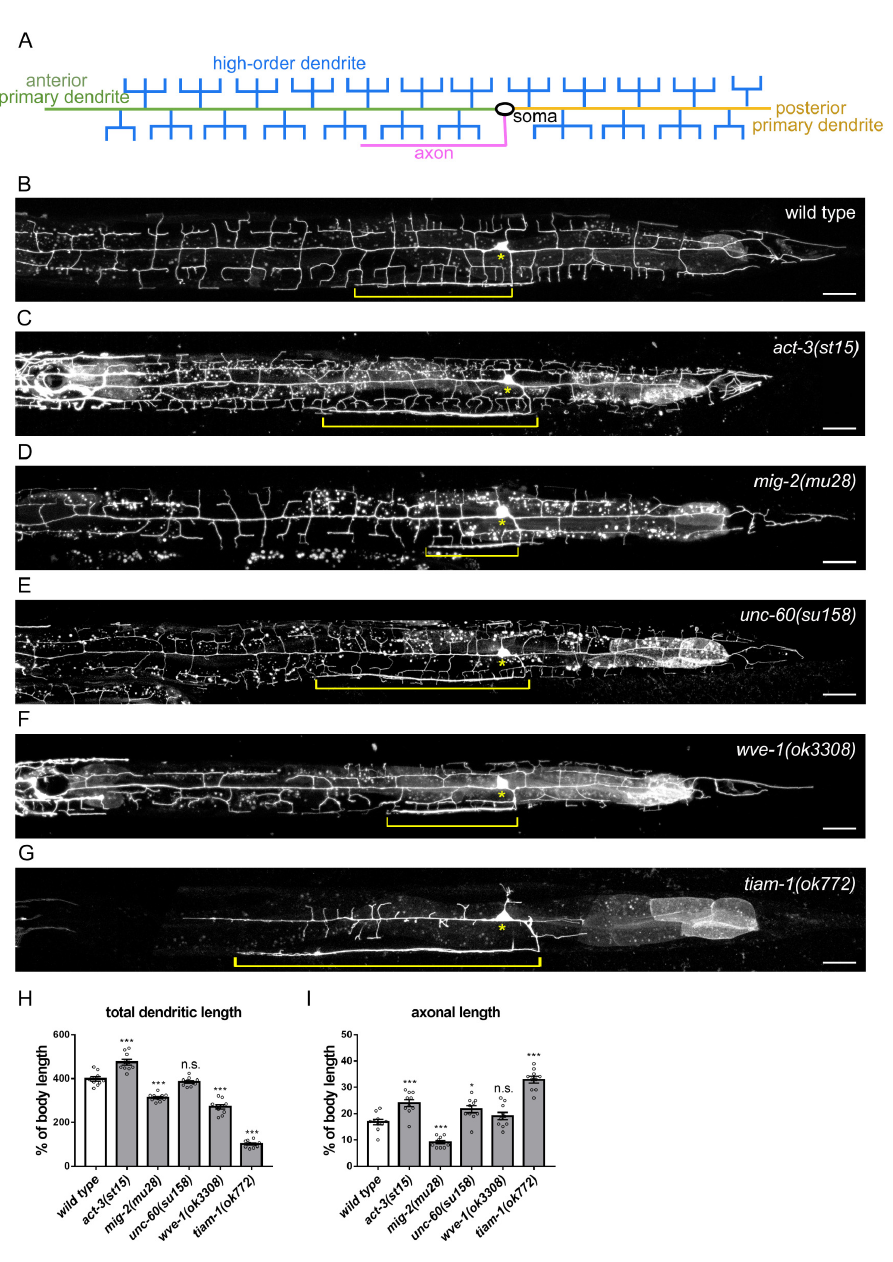
Fig 1. Actin regulators have distinct roles in axonal and dendritic morphogenesis. (A) Diagram of PVD neuron morphology. (B-G) PVD neuron expressing myr::mCherry under Pdes-2 promoter ( ntuIs1 ) in wild-type (B), act-3 (st15) (C), mig-2(mu28) (D), unc-60(su158) (E), wve-1(ok3308) (F), and tiam-1(ok772) (G). Brackets indicate the axons and asterisks indicate the cell body. Scale bar, 20 μ m. All worm images were oriented with the anterior toward left and the ventral toward down in this and the following Figures. (H and I) Quantification of total dendritic length (H) and axonal length (I) relative to the body length in wild type and indicated mutants. Error bar represents SEM. n = 10. One-way ANOVA test. n.s., not significant, � P < 0.05, �� P < 0.01, ��� P < 0.001, compared to wild type.